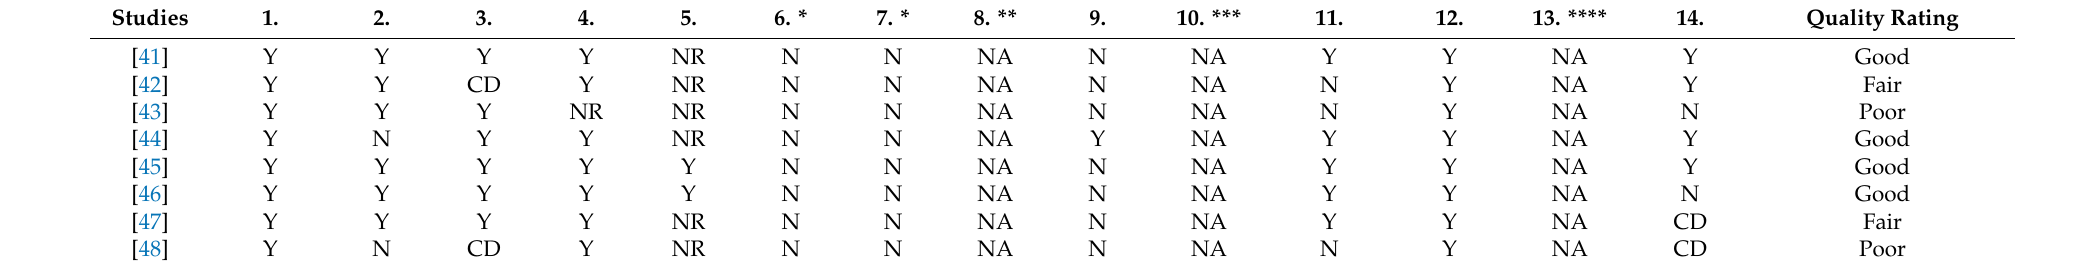
Table 1. Results of quality assessment of the cross-sectional studies (Victims